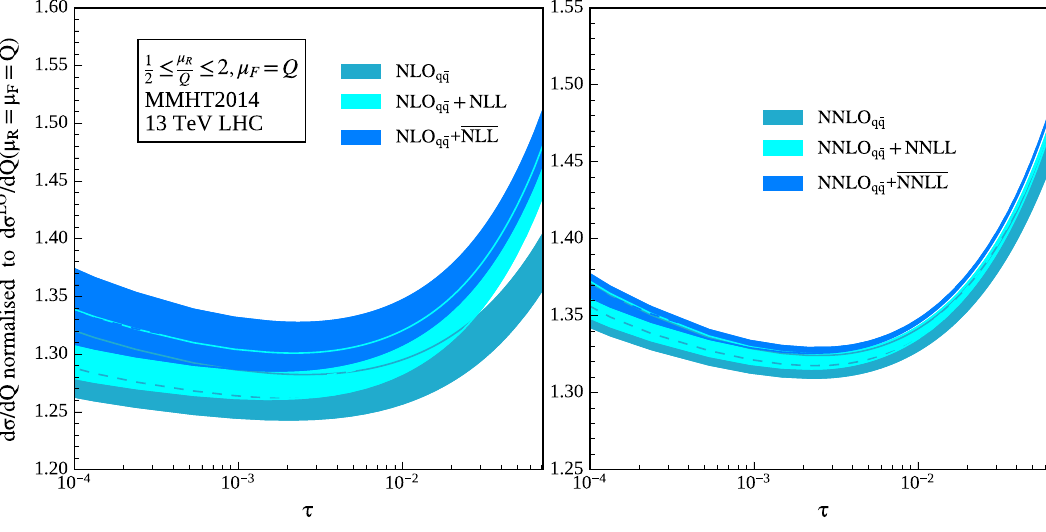
Fig. 13 μ R variation between SV and SV + NSV matched to NNLO q ¯ q with the scale μ F held fixed at Q in q ¯ q